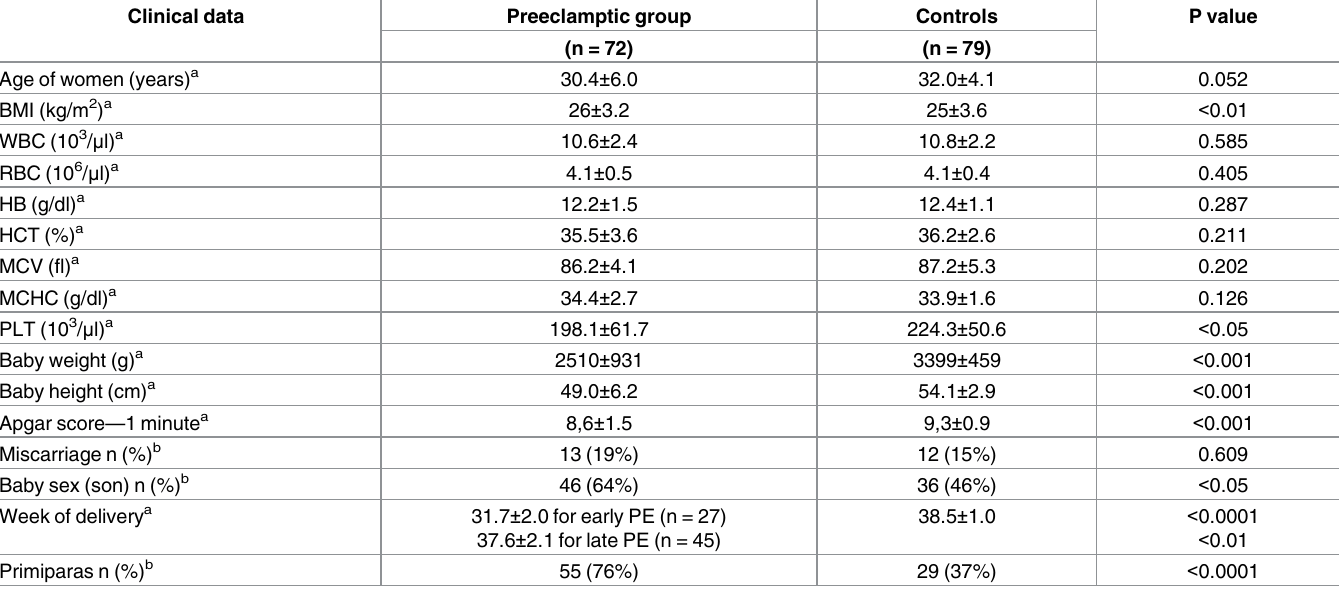
Table 2. Comparison of clinical data within the study